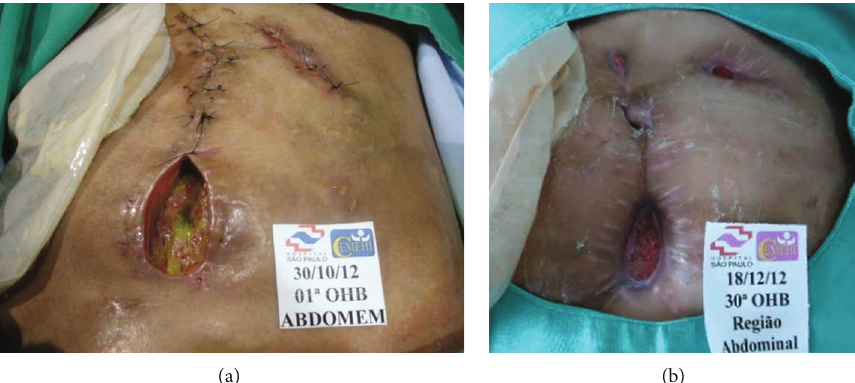
Figure 3: Enterocutaneous fi stula with active draining at the beginning of hyperbaric oxygen therapy (a). After 30 sessions, closure of the fi stula tract was observed